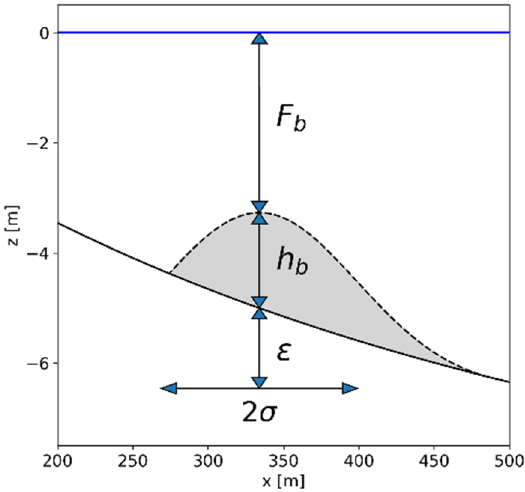
Figure 3. Cross-shore profile of idealized nearshore berm.